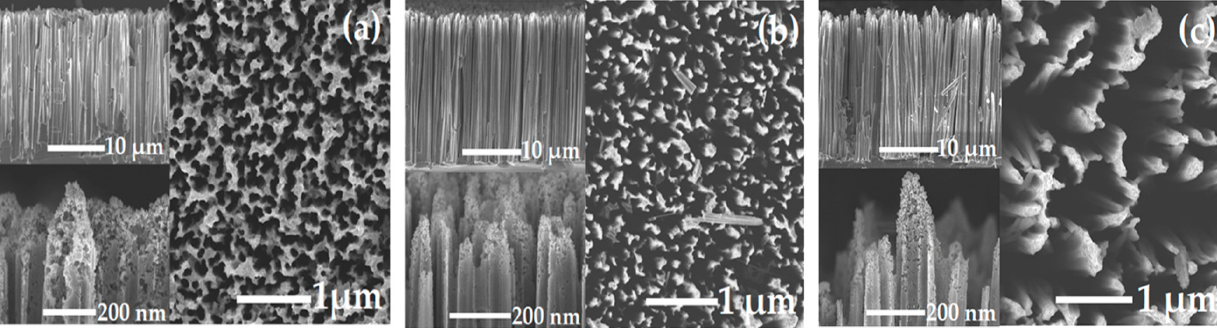
Figure 4. TEM images of ( a ) individual SiNW with deposited Au-NPs and ( b ) tip of such nan- owire.